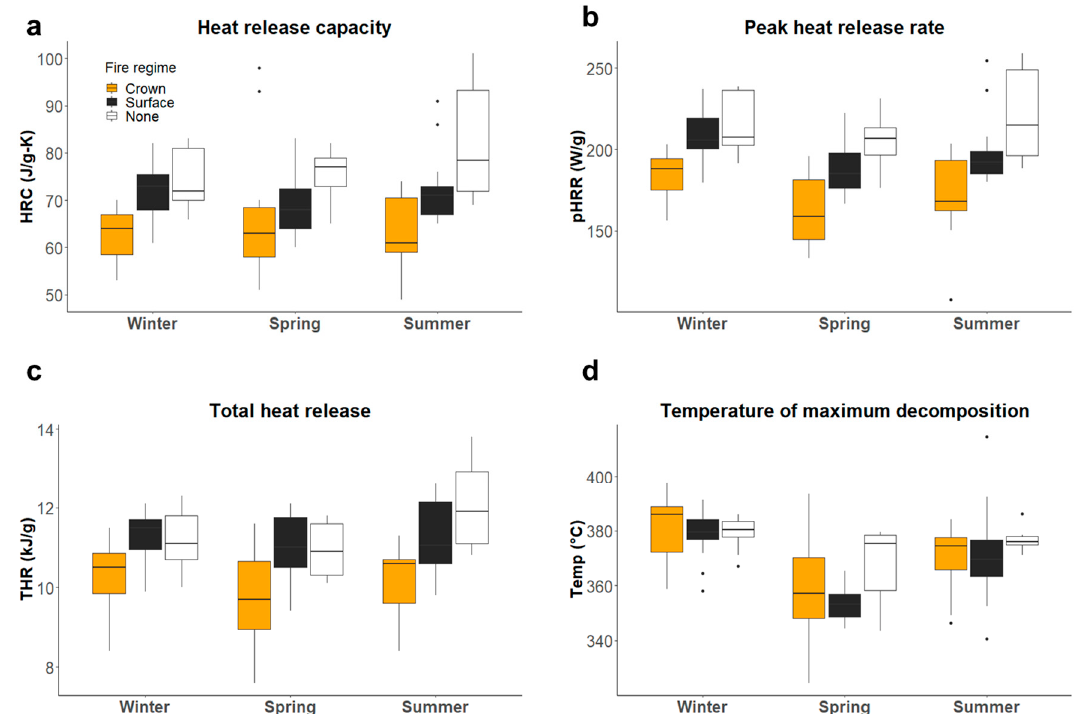
Figure 5. Flammability measurements of lab-dried pine needles. The flammability characteristics of lab-dried needles of pine species, grouped by fire regime and season, are shown. The flammability characteristics were determined by microcalorimetry analysis (( a )—heat release capacity; ( b )—peak heat release rate; ( c )—total heat release; ( d )—temperature of maximum decomposition). The boxes represent the interquartile range, with the median indicated; n = 15 (crown), 15 (surface) and 9 (none), with five species from both crown and surface fire regimes and three none fire species.